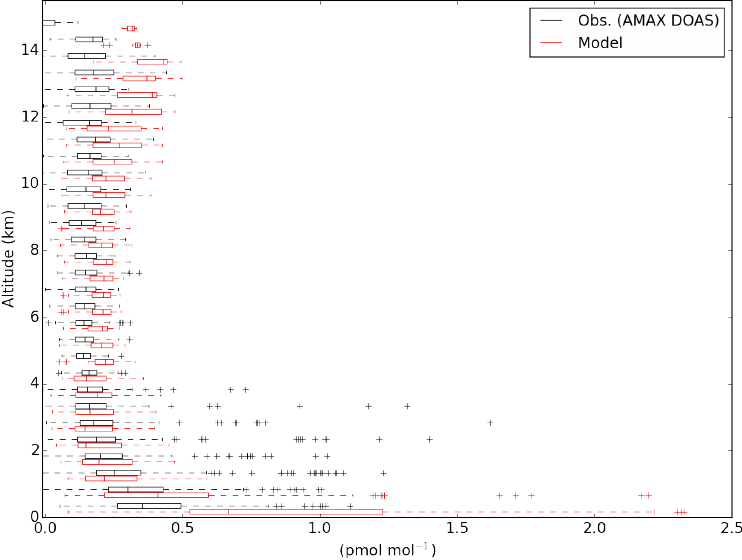
Figure 8. Vertical comparison of the model (“Cl + Br + I”) and measured iodine oxide (IO) during TORERO aircraft campaign (Volkamer et al., 2015; Wang et al., 2015). Model and observations are in red and black respectively. Values are considered in 0.5km bins, with observations and modelled values at the same location and time (as described in Sect. 2) shown side-by-side around the midpoint of each bin. Measurements were taken aboard the NSF/NCAR GV research aircraft by the University of Colorado airborne multi-axis DOAS instrument (CU AMAX-DOAS) in the eastern Pacific in January and February 2012 (Volkamer et al., 2015; Wang et al., 2015). The box plot extents give the interquartile range, with the median shown within the box. The whiskers give the most extreme point within 1.5 times the interquartile range. Locations of observations are shown in Fig.